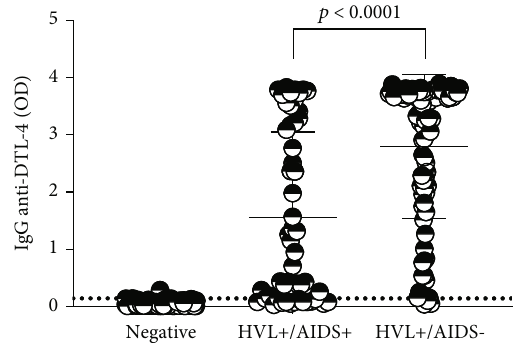
Figure 8: Evaluation of the reactivity of samples from coinfected patients from di ff erent locations assayed with DTL-4-ELISA. Sera from HVL+/AIDS- patients ( n = 167 ), sera from HVL+/AIDS+ patients ( n = 6 2), and sera from healthy donors ( n = 169 ) were included in this assay. Sera samples were diluted at 1:100. The dotted line represents the cut-o ff